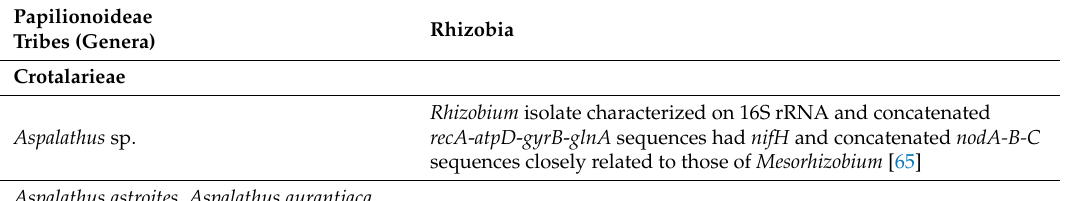
Table 3. Legume–rhizobia symbioses of species in the sub-family Papilionoideae with indeterminate nodules excluding the